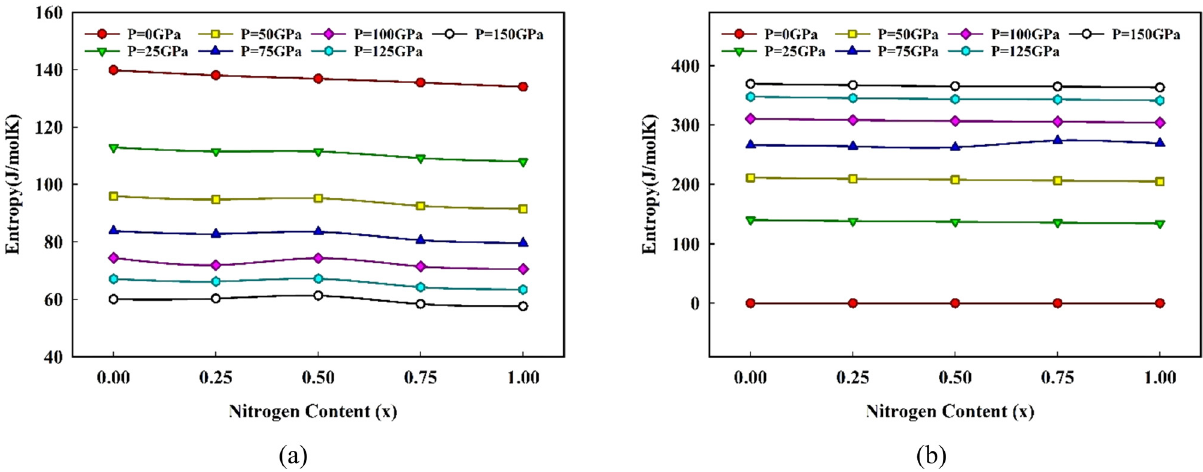
Figure 4: Entropy of ZrC ( 1 − x ) N x as a function of nitrogen content ( x ) for ( a ) di ff erent pressures at 300 K and ( b ) di ff erent temperatures at zero